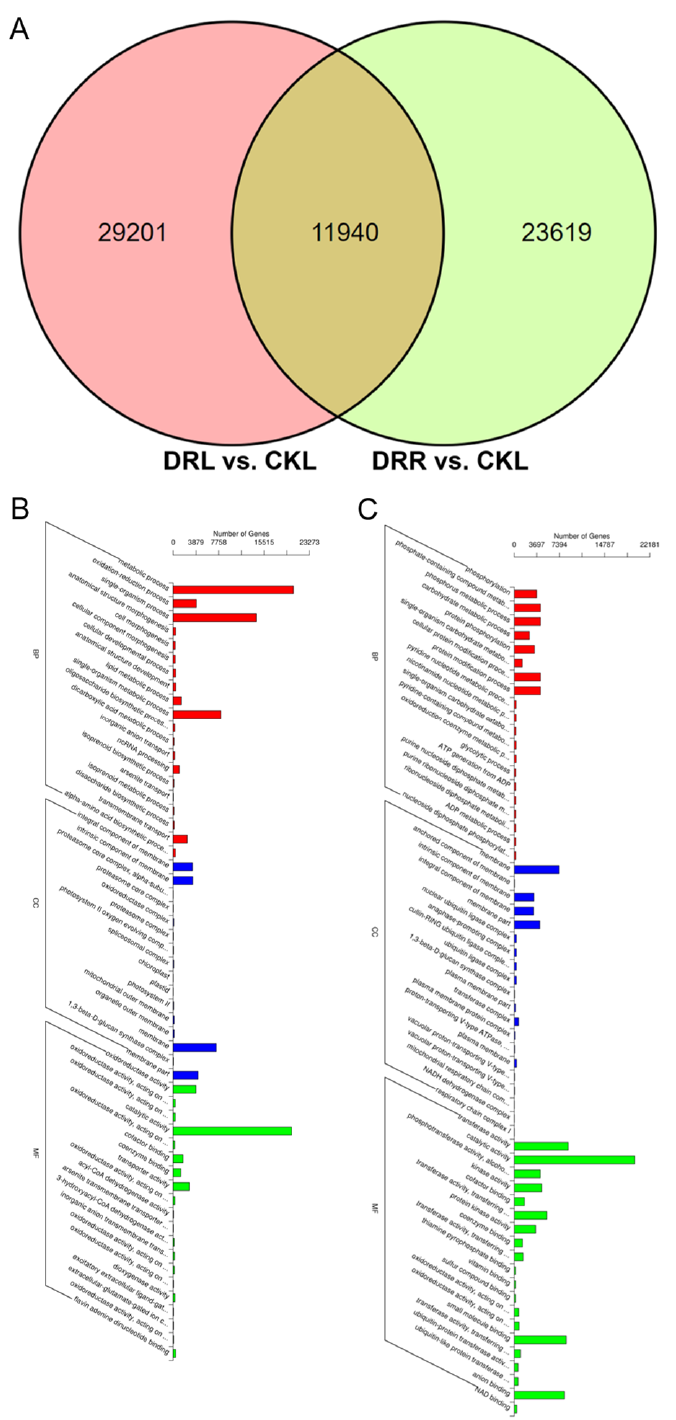
Figure 3. Biological function annotation of differentially expressed genes (DEGs). ( A ) Venn diagram for DEGs in the leaves in control versus drought conditions (DRL versus CKL) and roots in control versus drought conditions (DRR versus CKR) comparisons. ( B ) Gene Ontology (GO) enrichment analysis for DRL versus CKL. ( C ) GO enrichment analysis for DRR versus CKR.